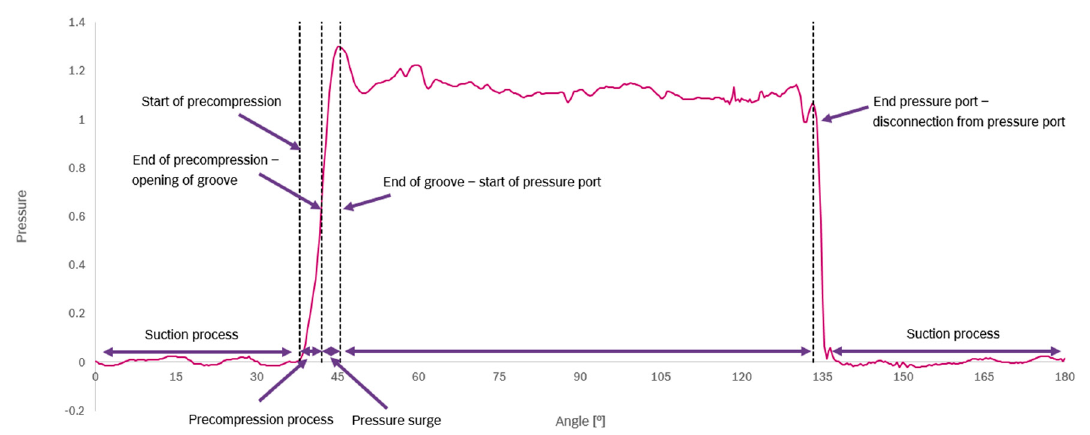
Figure 3. Characteristic pressure curve of a rotating displacement chamber.